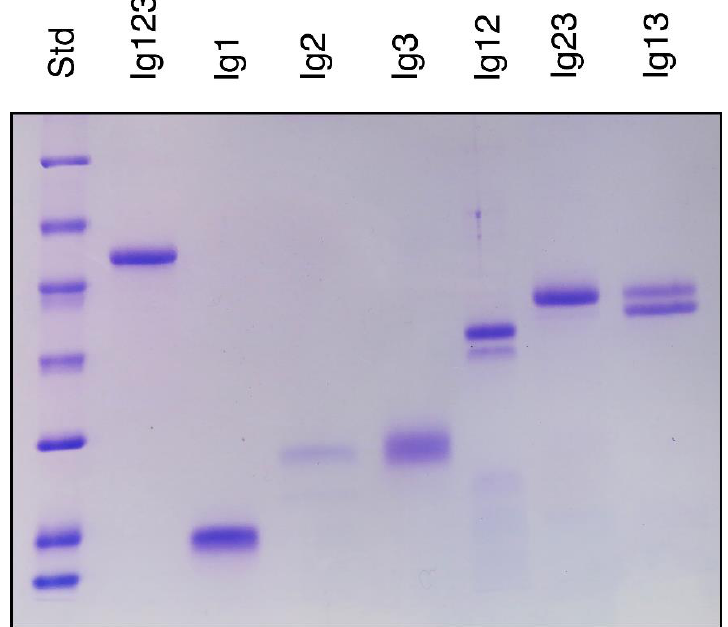
Figure 2. Polyacrylamide gel displaying the individual constructs expressed in human cells. Polypeptides (3 μg/lane except for Ig2) were resolved on a 12.5% SDS polyacrylamide gel and stained with Coomassie blue. In the case of Ig2, only 0.8 μg/lane was loaded due to the consistently low yields obtained with this construct. Standard proteins are included at the left-hand side with molecular masses of 116, 66, 45, 35, 25, 18.4 and 14.4 kDa. The figure shows the results from one representative experiment out of three. Note that only Ig12 and Ig13 migrate as a closely spaced doublet, suggesting incomplete glycosylation, whereas the other polypeptides migrate as single bands.